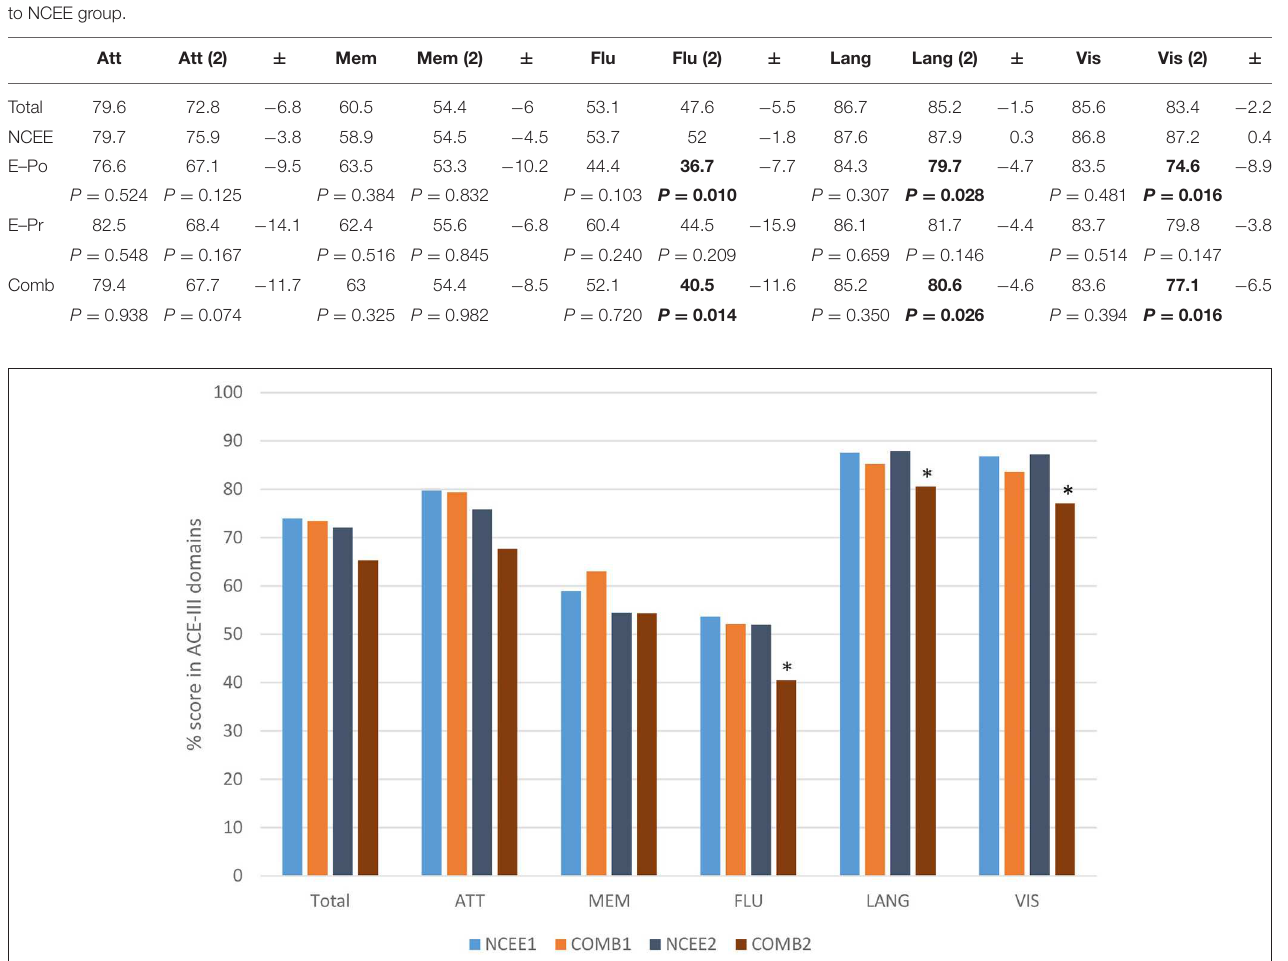
experience epileptic seizures demonstrate a larger, multi-domain, decline in cognitive function than those without seizures. This is